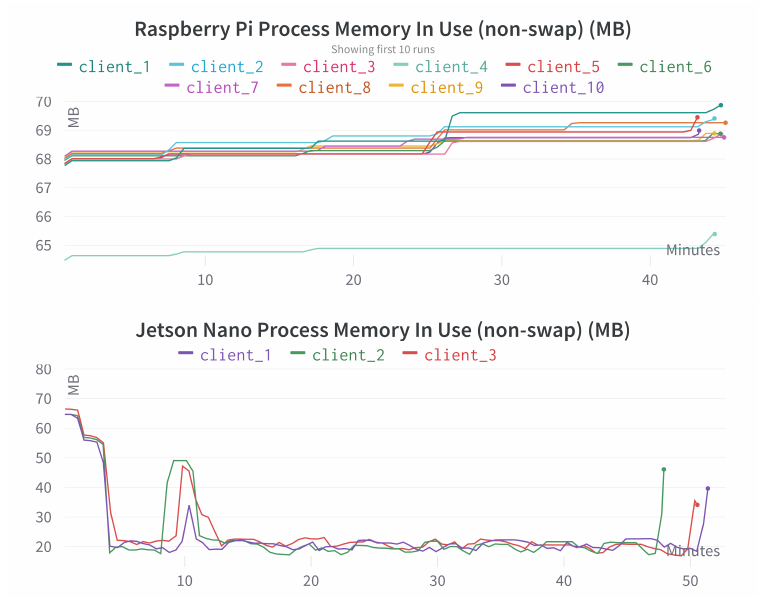
Figure 11. Process memory in use comparison for different Raspberry Pi and Jetson Nano de- vices. The x-axis represents the time in minutes, the y-axis represents the used process memory in megabytes